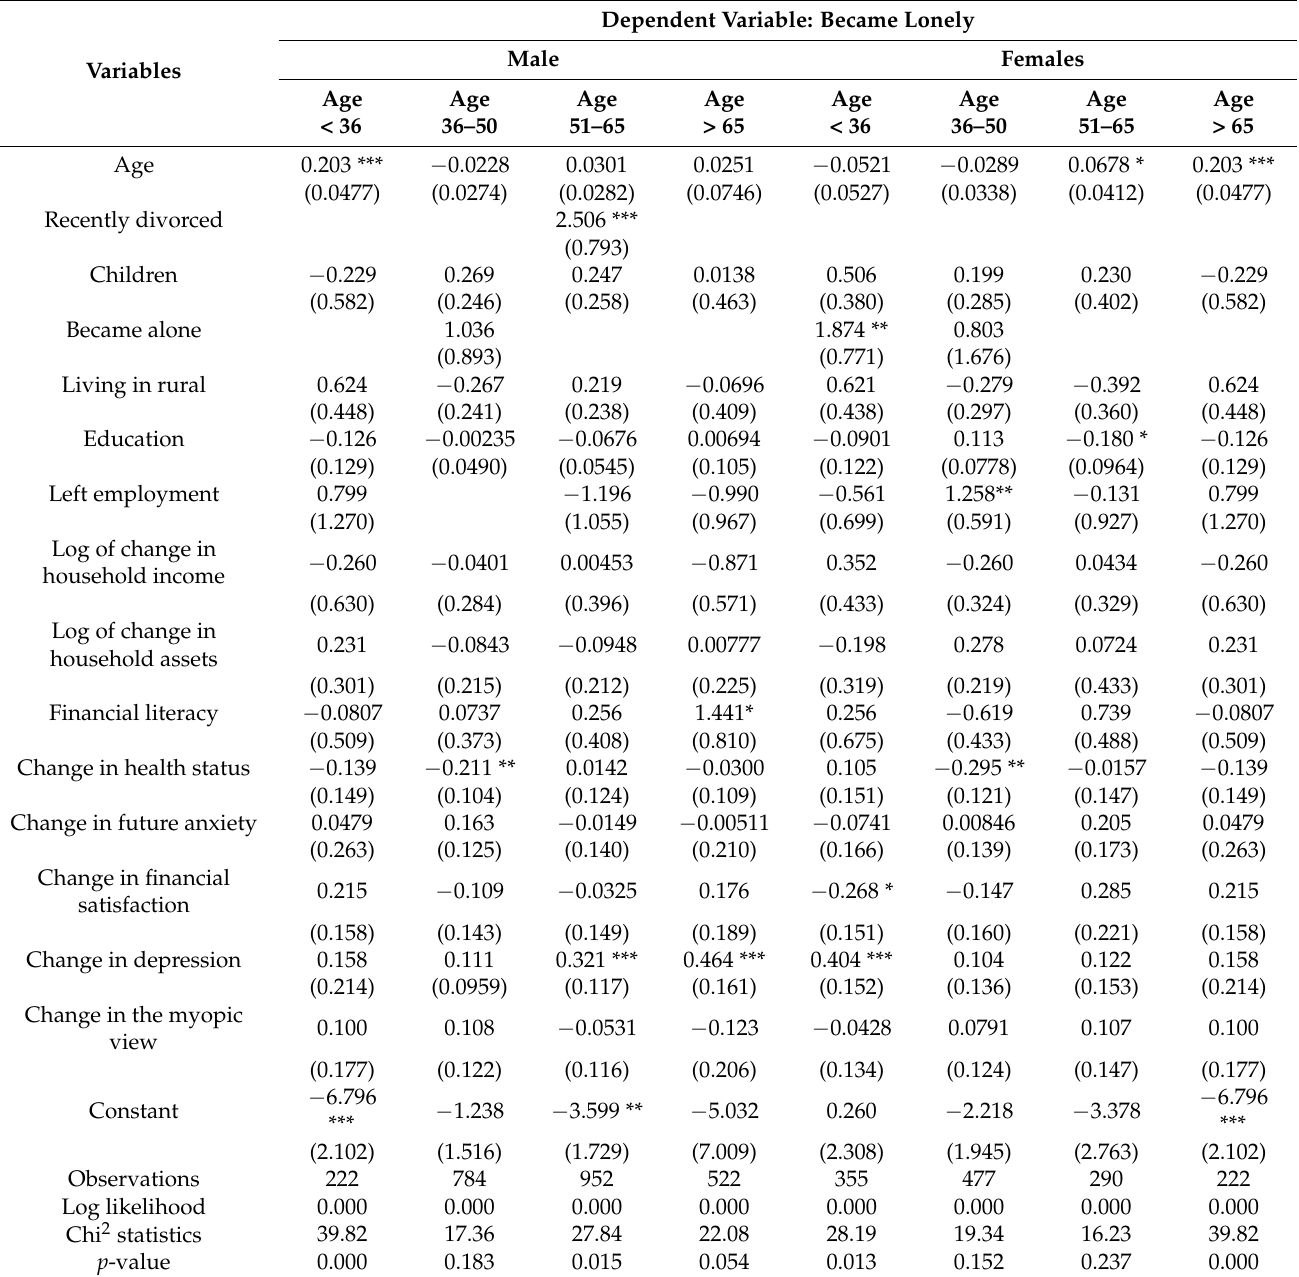
Table 10. Logit regression results of becoming lonely in 2021 (subsample analysis: gender and age